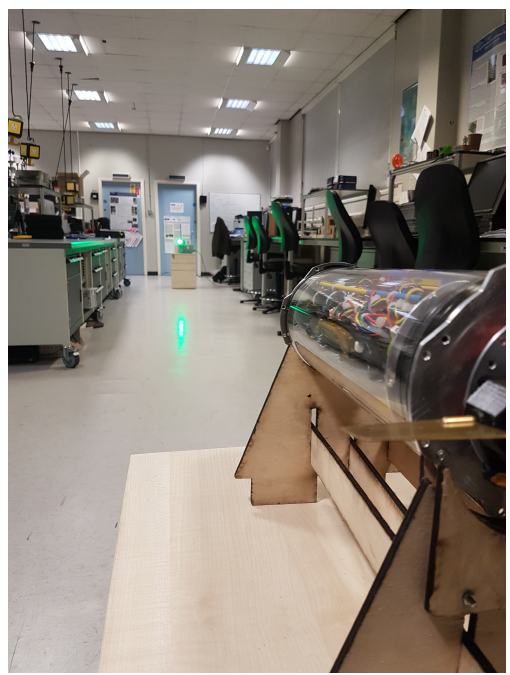
Figure 7. Experiment 2 setup.